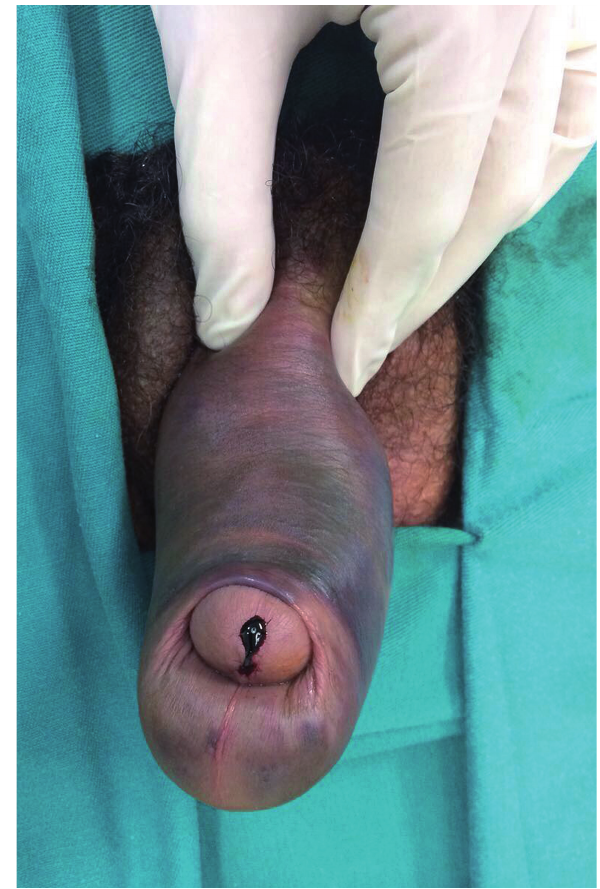
figure 1 - After a “doggy style” position the patient present penile fracture, we can observe a great hematoma and the typical aspect of eggplant deformity and meatal bleeding. During the surgery we identified a bilateral rupture of the cc and transection of the penile